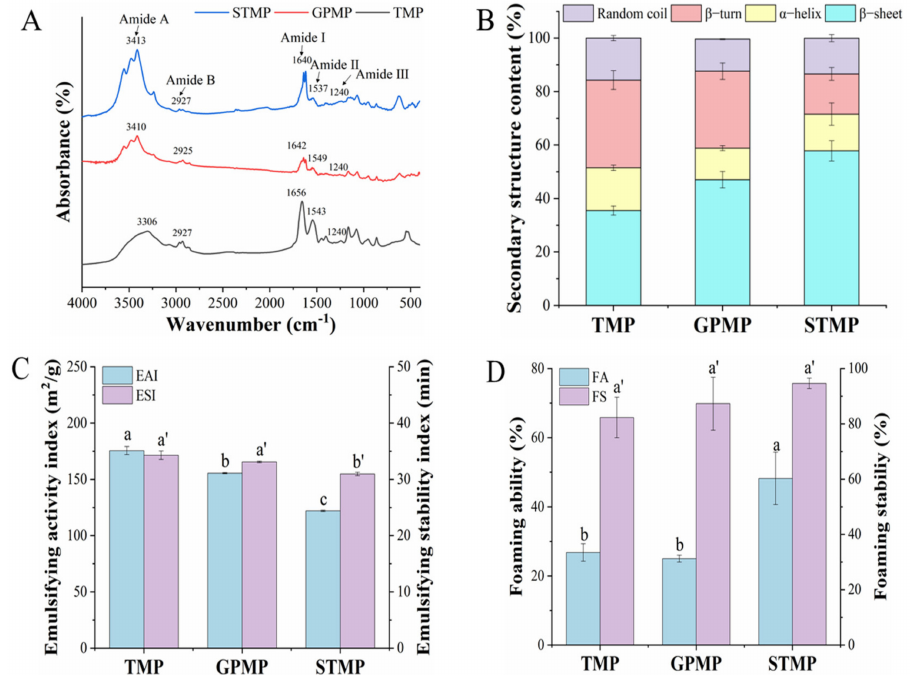
Figure 3. FTIR spectra ( A ), secondary structure contents ( B ), emulsion properties ( C ) and foaming properties ( D ) of MPs. Different lowercase letters indicate significant differences at p <